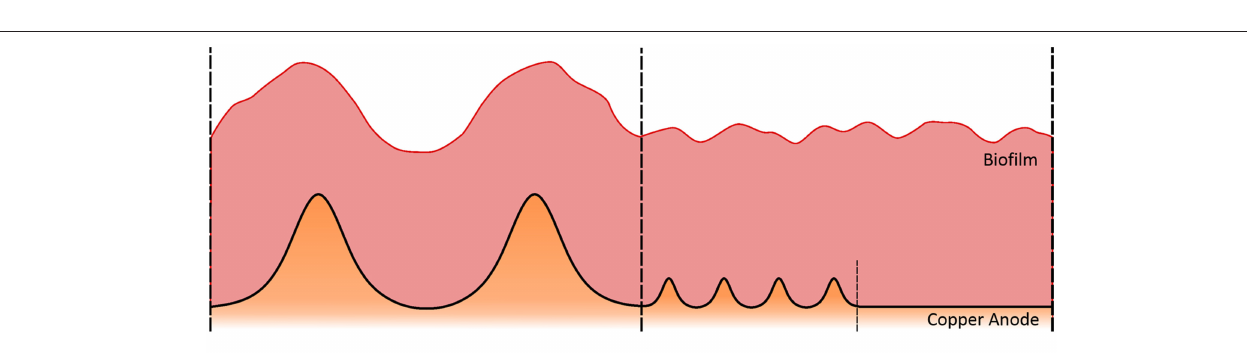
FIGURE 6 | Schematic picture showing electrode structures of different sizes overgrown by a microbial